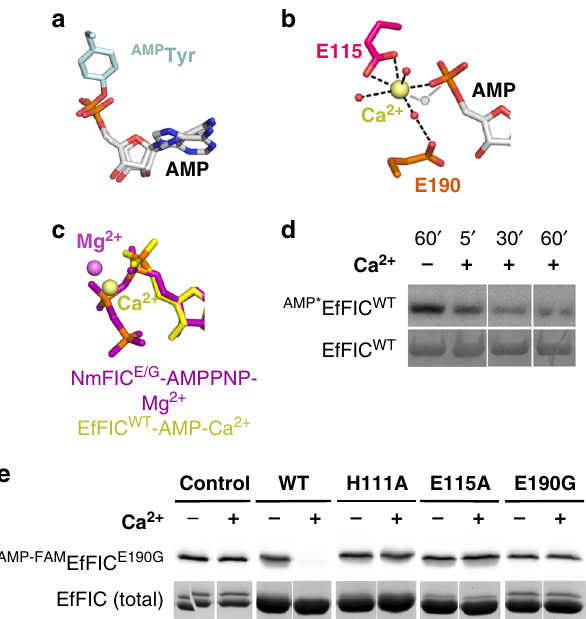
Fig. 2 FIC protein from Enterococcus faecalis (EfFIC) is a deAMPylator in the presence of Ca 2 + . a AMP bound to EfFIC WT superposes with the AMP moiety of AMPylated CDC42 in complex with the FIC protein IbpA (ref. 6 , PDB 4ITR). Superposition was carried out based on the FIC motif. b Close- up view of Ca 2 + bound to EfFIC WT -AMP. Interactions of Ca 2 + are indicated by dotted lines. Water molecules are shown as red spheres. The predicted position of the water molecule responsible for in-line nucleophilic attack is indicated in gray. Note that this water molecule completes the heptahedral coordination sphere of Ca 2 + . c Ca 2 + bound to EfFIC WT -AMP is shifted by 1.3 Å with respect to Mg 2 + bound to NmFIC E/G -AMPPNP. The superposition is done on the FIC motif. d EfFIC WT has deAMPylation activity in the presence of Ca 2 + . EfFIC WT was autoAMPylated with [ α - 32 P]- ATP in the presence 100 nM Mg 2 + for 1 h, then the sample was incubated for 60 min with EDTA alone (1 mM) (lane − ) or 5, 30, and 60 min with EDTA (1 mM) and an excess of Ca 2 + (10 mM) (lanes + ). AMPylation levels were analyzed by autoradiography (upper panel). The total amount of EfFIC WT in each sample was measured by Coomassie staining (lower panel). e Key residues of the AMPylation active site are required for deAMPylation. EfFIC E190G was left to auto-AMPylate for 1 h in the presence of the fl uorescent ATP analog ATP-FAM and Mg 2 + , then